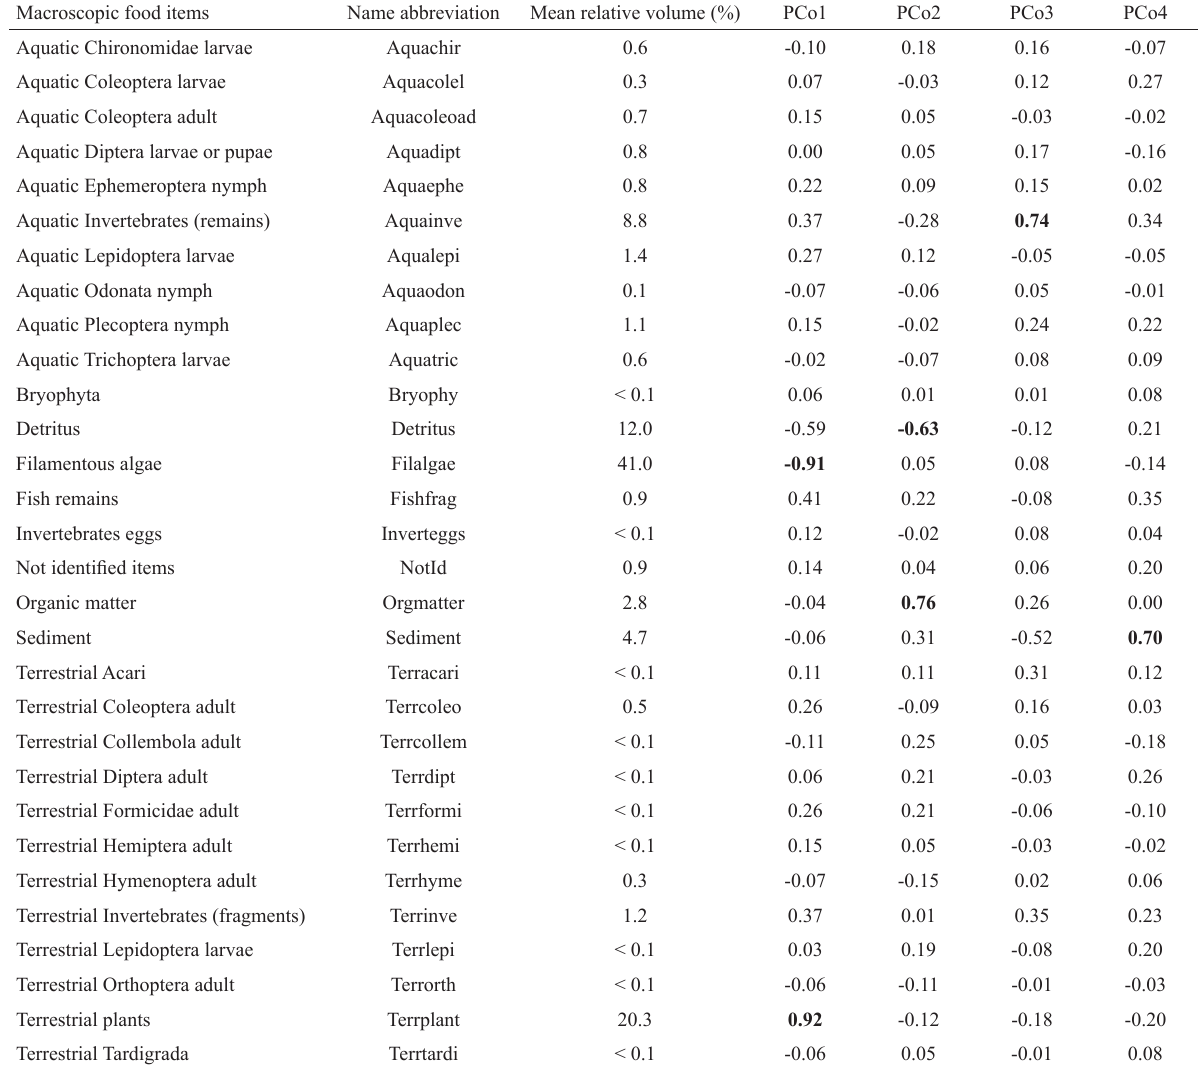
Table 1. Mean relative volume and correlation coefficients between food items and the Principal Coordinates (PCo) of a PCoA based on diet composition of the stream-dwelling characid fish Deuterodon stigmaturus . Boldface highlights the highest correlations.